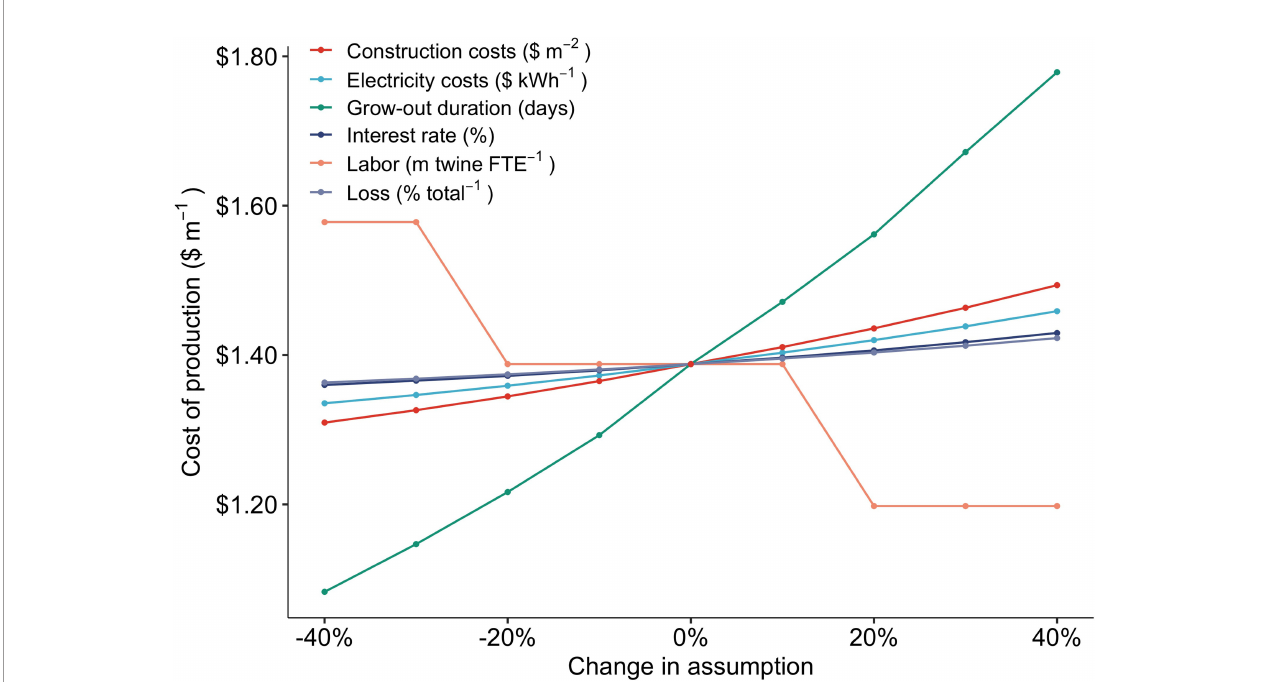
FIGURE 4 | Change in production costs ($ m -1 ) as a result of proportional (%) changes in six key model assumptions: construction costs ($ m -2 ), electricity costs ($ kWh -1 ), sporophyte grow out duration (days), interest rate on loans (%), the facility labor requirements (m twine per FTE employee), and the annual twine loss (% total -1 ).